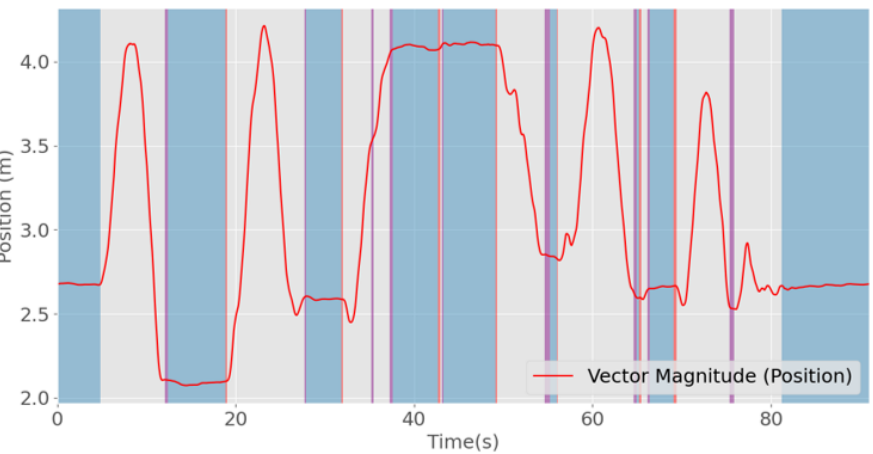
Figure 9. Example of a trial classification using the Random Forest classifier with and without median filtering (blue background, true positives (correctly identified stopped periods); gray background, true negatives (correctly identified periods of movement), purple background, false positives (wrongly labeled as stopped periods); red background, false negatives (wrongly labeled as moving